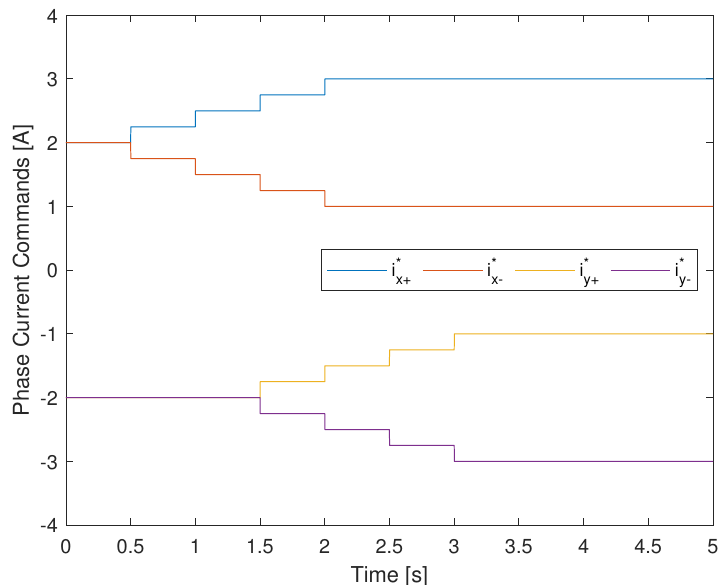
Figure 18. Reference phase currents used in the experiment.